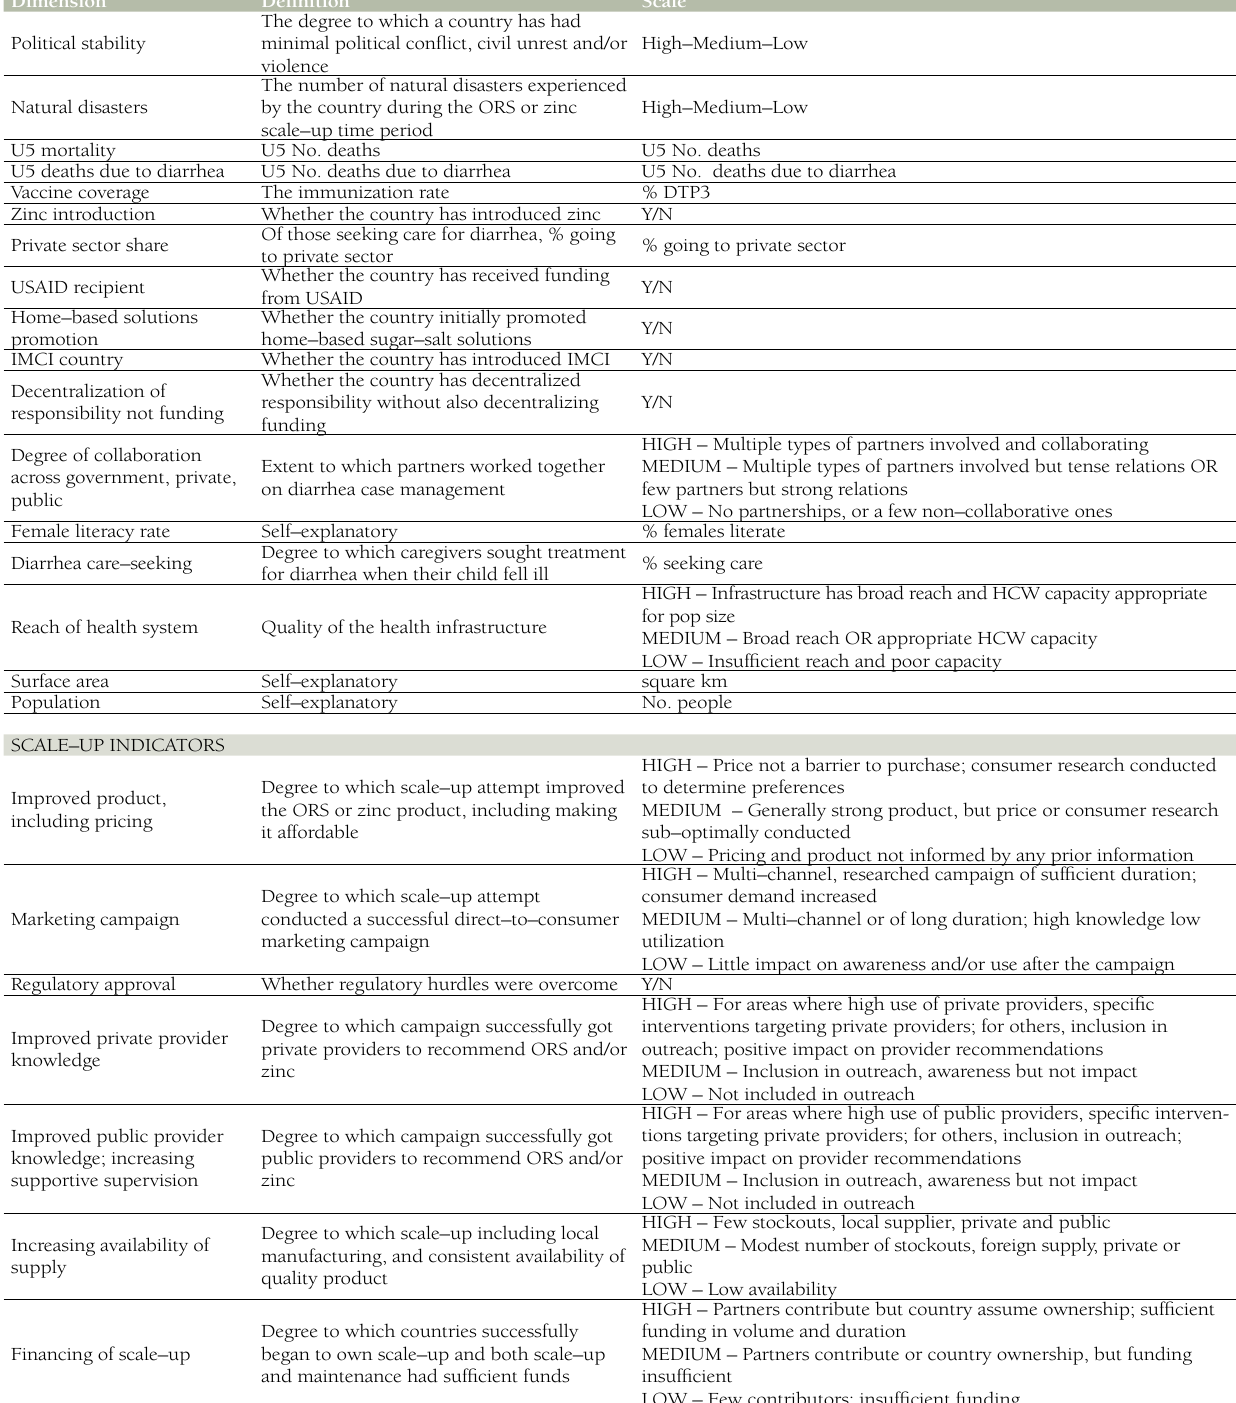
Table 4. Dimensions of implementation and their scales Dimension Definition Scale Political